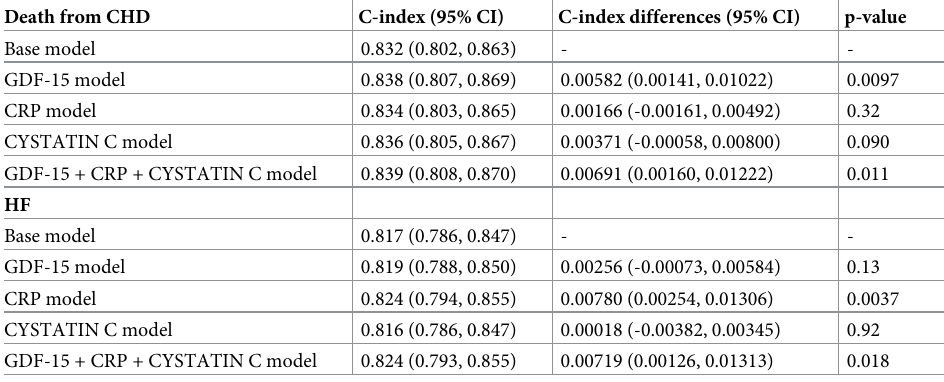
Table 2. C-indices for 25-year prediction of death from CHD and HF. Death from CHD C-index (95% CI) C-index differences (95% CI) p-value Base model 0.832 (0.802, 0.863)